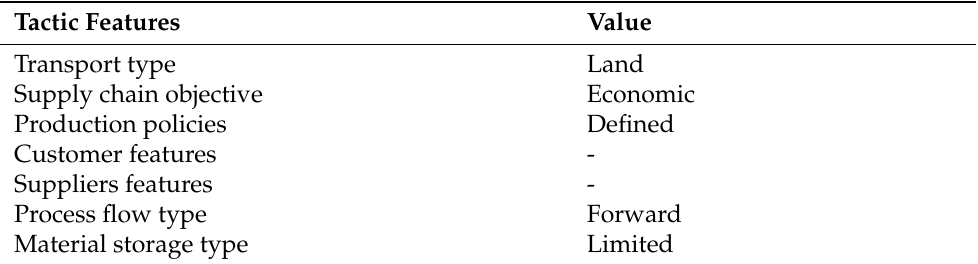
Table 3. Tactic features of the organization for system characterization.